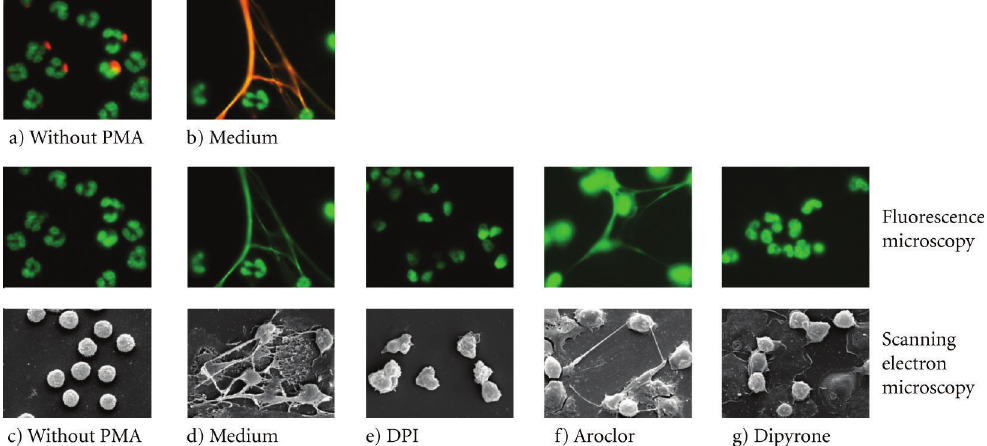
Figure 7: Release of NETs by neutrophils after exposure to various ROS inhibitors assessed by fluorescent and scanning electron microscopy (SEM). Freshly isolated human neutrophils were preincubated with various ROS inhibitors (20 µ M DPI, 38 µ M Aroclor, and 200 µ M Dipyrone) for 30 min at 37 ◦ C. NET release was induced by 20nM PMA, and the samples were fixed after 4h. NET release was detected by fluorescent microscopy and SEM. (a-b) DNA staining with SYTOXgreen and neutrophil elastase or (c–g) with SYTOXgreen alone. (a) and (c) unstimulated neutrophils, (b) and (d) PMA-stimulated neutrophils in medium (without inhibitor), (e–g) PMA-stimulated neutrophils exposed to a ROS